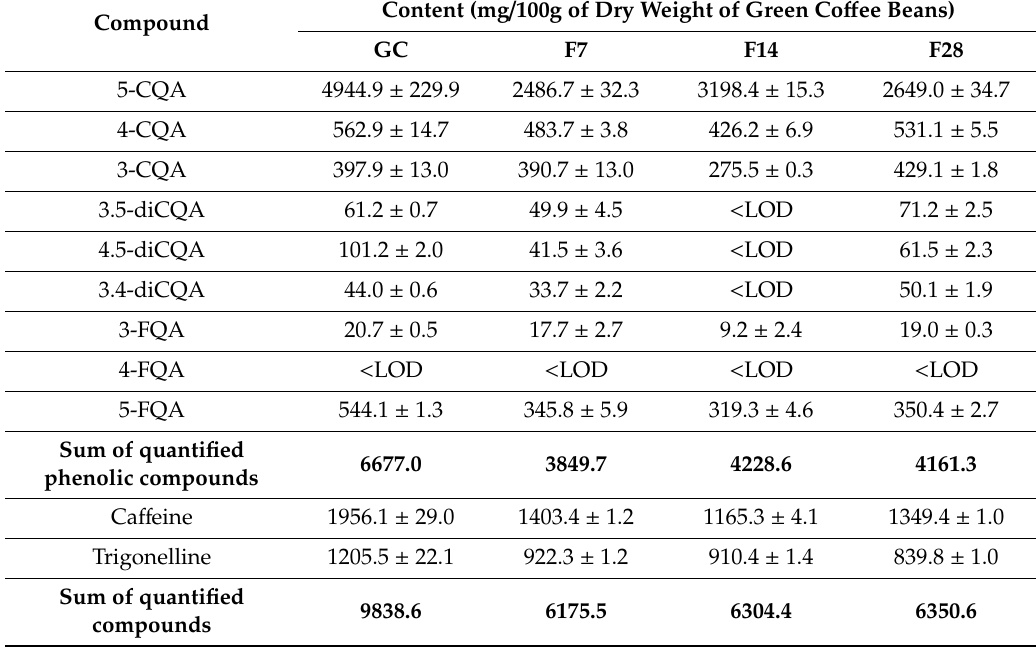
Table 3. Quantification results obtained for GC, F7, F14 and F28 extracts. Values are means ± standard deviation (SD) of triplicate. LOD—limit of